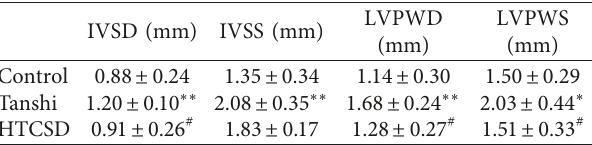
Table 3: Comparison of LVPW and IVS measured by echocar- diography (mean ± S .D, n �